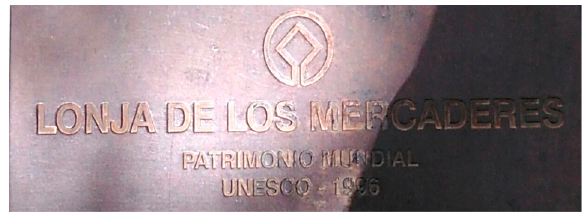
Figure 19. Valencia: Spanish-only sign on a traders’ market .